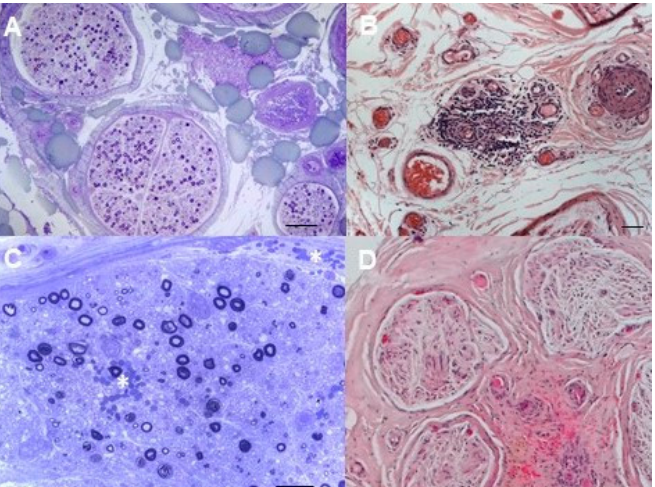
Figure 2. Sural nerve biopsy from cryoglobulinemic neuropathy. ( A ) Asymmetric focal loss of myelin fibers and epineurial perivascular inflammatory infiltration are evident. (semithin section, toluidine blue, original magnification, 10×; bar 100 μ m). ( B ) A perivascular infiltrate of lympho-monocytes is recognizable in epineurium. (paraffin section, H&E, original magnification 20×; bar 50 μ m). ( C ) Active axonal degeneration characterizes the pathological process together with endo- neurial and subperineurial petechiae (*) (semithin section, toluidine blue, original magnification 40×; bar 50 μ m). ( D ) Haemorrhagic suffusions (petechiae) are also present in epineurium (paraffin section, H&E, original magnification 10×; bar 50 μ